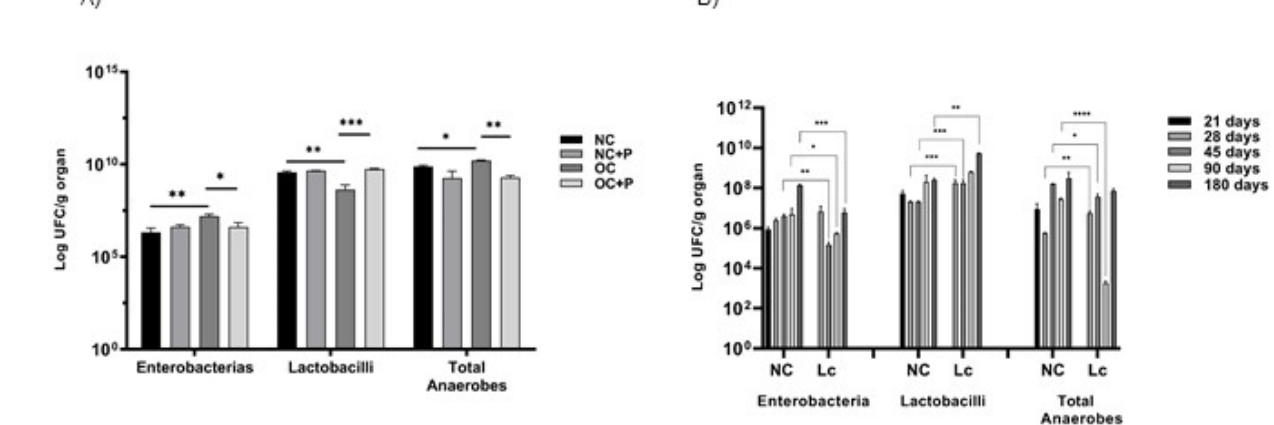
Figure 2. Microbial population in the large intestine. Total population of enterobacteria, lactobacilli and anaerobes was evaluated in the large intestine of: ( A ) obese mice and ( B ) mice of 21, 28, 45, 90 or 180 days for the senescence study. Results were expressed as CFU/mL per gram of large intestine (mean ± SD) of three independent experiments. (NC) received a balanced diet and water; (NC+P) received a balanced diet and probiotic bacteria in the drinking water; (OC) mice fed a high-fat diet and water; (OC+P) mice fed a high-fat diet and a probiotic Lc 431 suspension. One-way ANOVA with Tukey’s correction for multiple comparisons * p < 0.05; ** p < 0.001; *** p < 0.001; **** p < 0.0001.